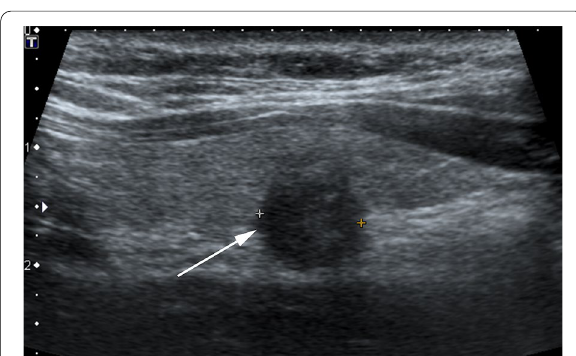
Fig. 7 57-Year-old female patient with 8 mm PTC with extrathyroid extension (ETE). Sagittal image of the right lobe of thyroid gland shows the hypoechoic PTC extending beyond the margin of the gland posteriorly into the perithyroid connective tissue (arrow). The patient was not offered